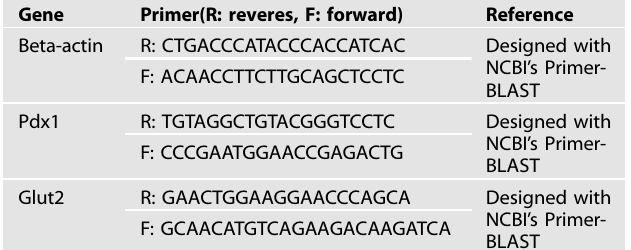
Table 1. Primers for quantitative real-time PCR analysis of gene